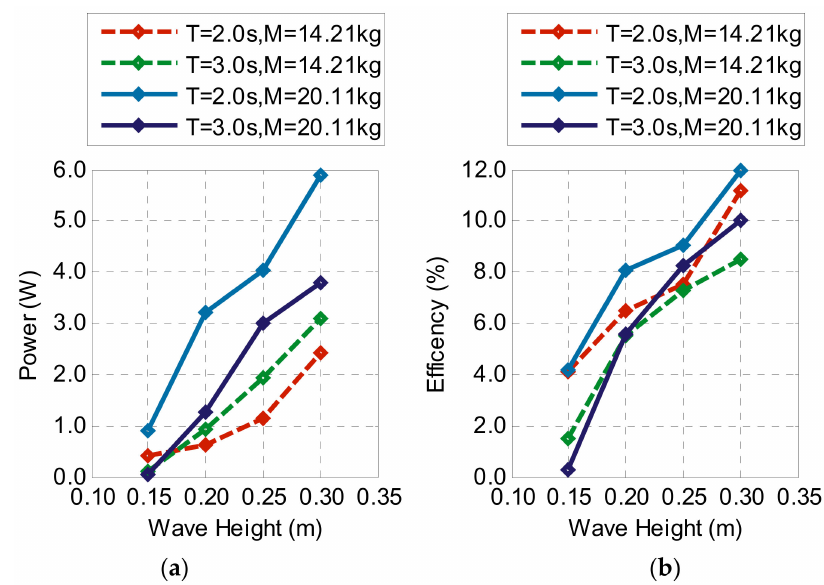
Figure 20. Power and e ffi ciency curves of the prototype in the in-wave tank experiments: ( a ) power curve; ( b ) e ffi ciency curve.